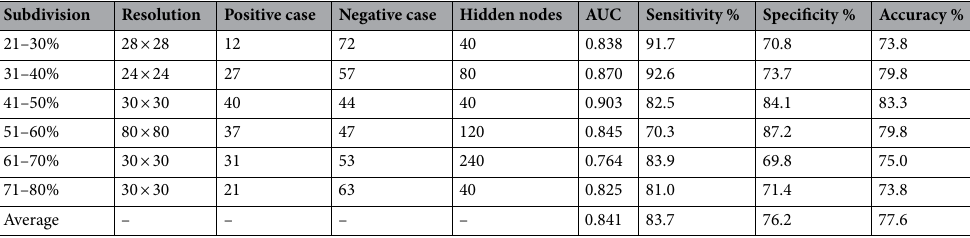
Table 1. ICH detection results using the validation set for the six subdivisions.